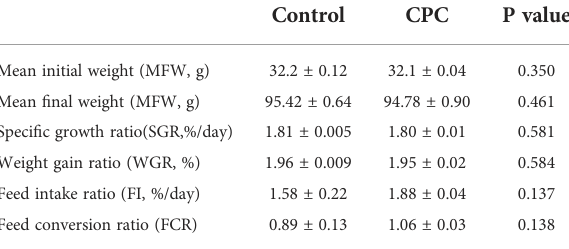
TABLE 3 Growth parameters of juvenile largemouth bass in the present study.